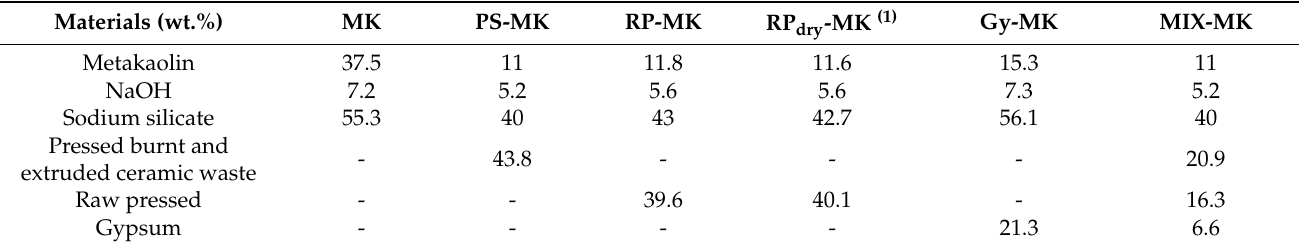
Table 2. Mix design of the geopolymeric samples prepared in this work (MK: neat geopolymer; Gy: gypsum waste; RP: raw pressed ceramic waste; PS: porcelain stoneware waste). In the MIX-MK sample, a mixture of all the used waste was